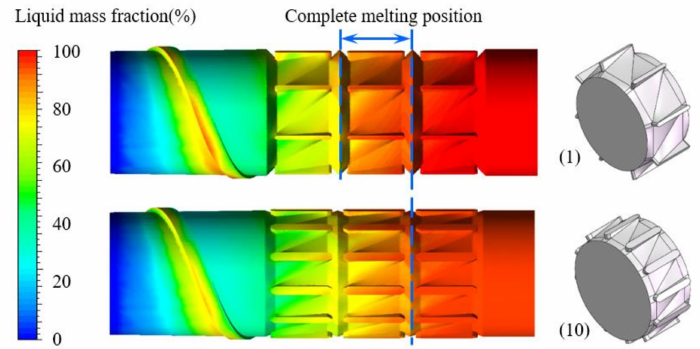
Figure 7. Liquid mass fraction distributions near the screw root for cases 1 and